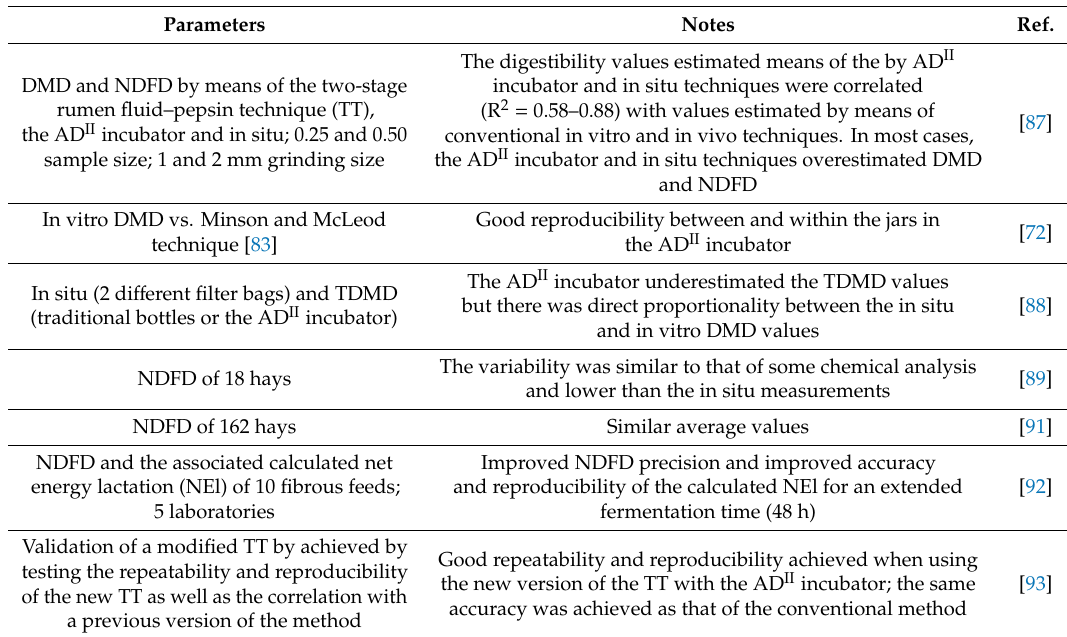
Table 4. Precision and accuracy of the method using the Ankom Daisy II incubator (AD II ).